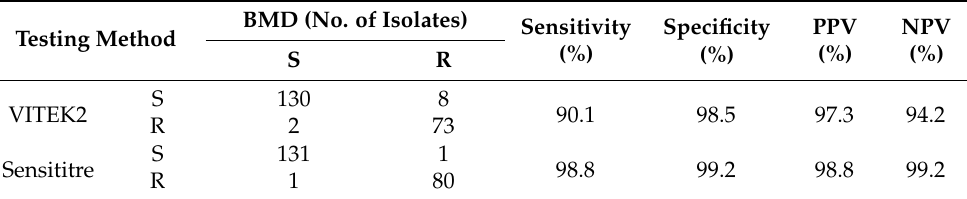
Table 3. The performance for detection of colistin resistance in Acinetobacter baumannii of different antimicrobial susceptibility testing methods.